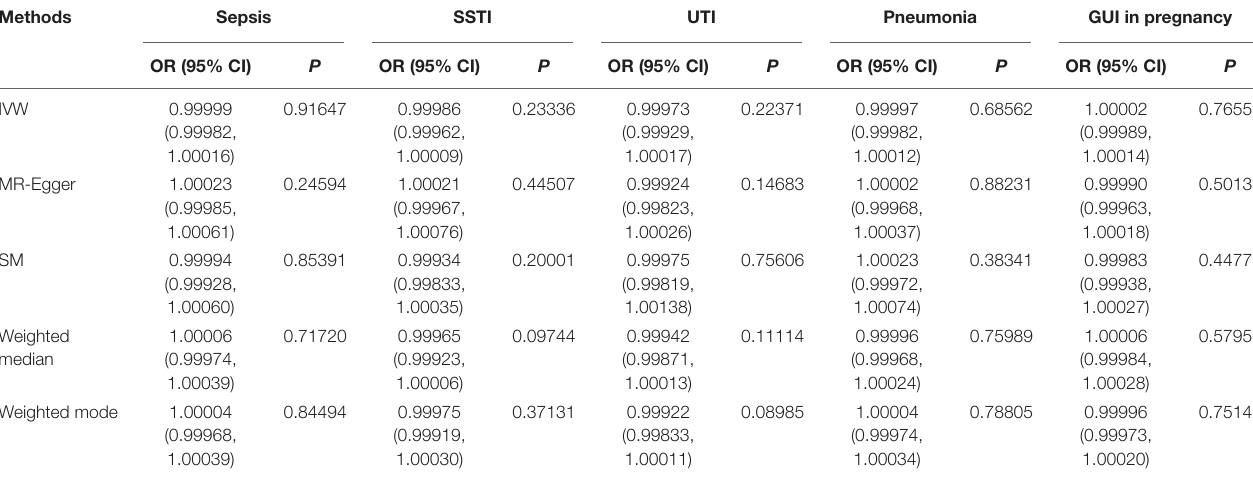
TABLE 1 | The association between T2DM and infections of odds ratios using different methodological approaches. Methods Sepsis SSTI UTI Pneumonia GUI in